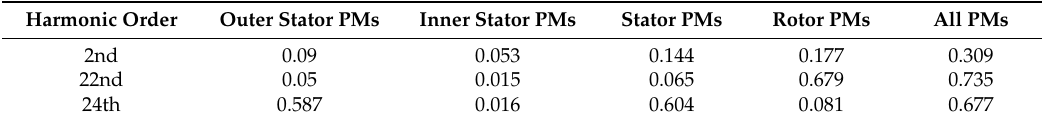
Figure 9. Outer airgap flux density with different excitation sources and corresponding harmonic spectra. ( a ) Flux density waveforms; ( b ) corresponding harmonic spectra. Table 4. Main outer airgap flux density harmonics amplitude (T).